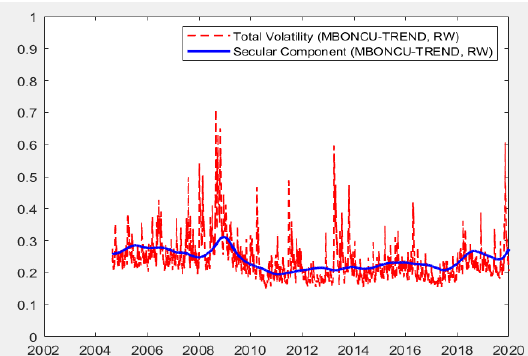
Figure 3. Total Variance and Long-Run Component with IPI-Trend.